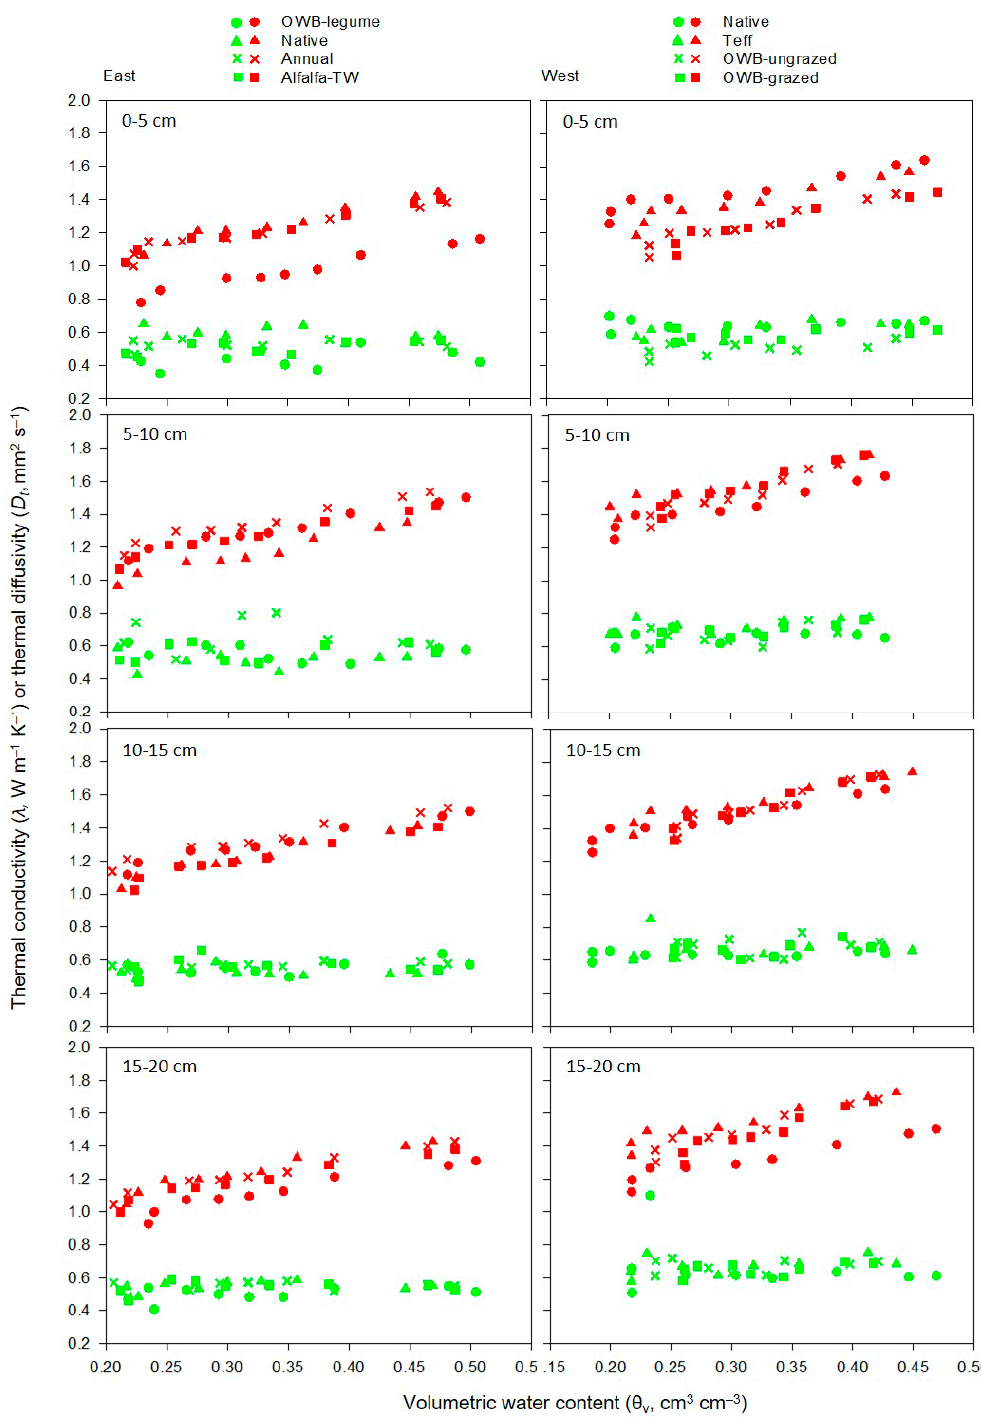
Figure 5. Measured soil thermal conductivity λ (red symbols) and thermal diffusivity D t (green symbols) as a function of volumetric water contents ( θ v ) corresponding to different applied pressure heads (i.e., 0, − 100, − 330, − 500, − 2000, − 3000, − 5000, − 10,000, and − 15,000 cm, as shown in Figure 4) at soil depths of 0–5, 5–10, 10–15, and 15–20 cm for all treatments in the east and west pasture area during a 2-year study period (2016–2017). Data were averaged across sampling points, replicates, and years. OWB, Old-World bluestem; TW, tall wheatgrass.